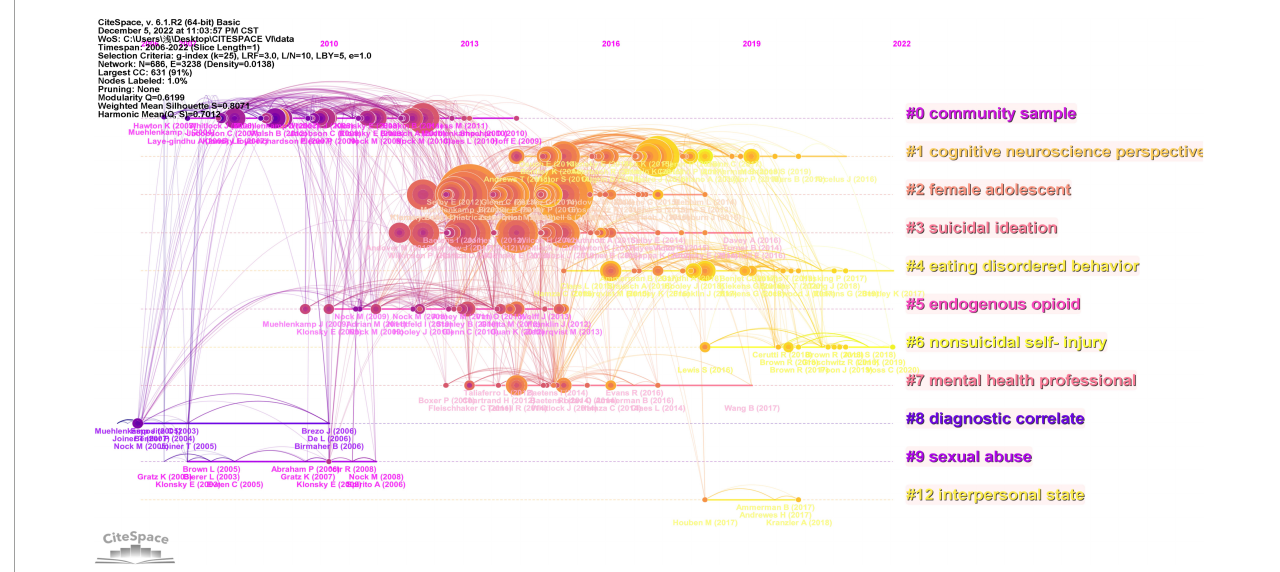
FIGURE10 The network of co-cited references timeline viewer by CiteSpace. Each horizontal axis is one cluster, the denser the clusters are, the more they represent the frontier in the field of non-suicidal self-injury (NSSI).